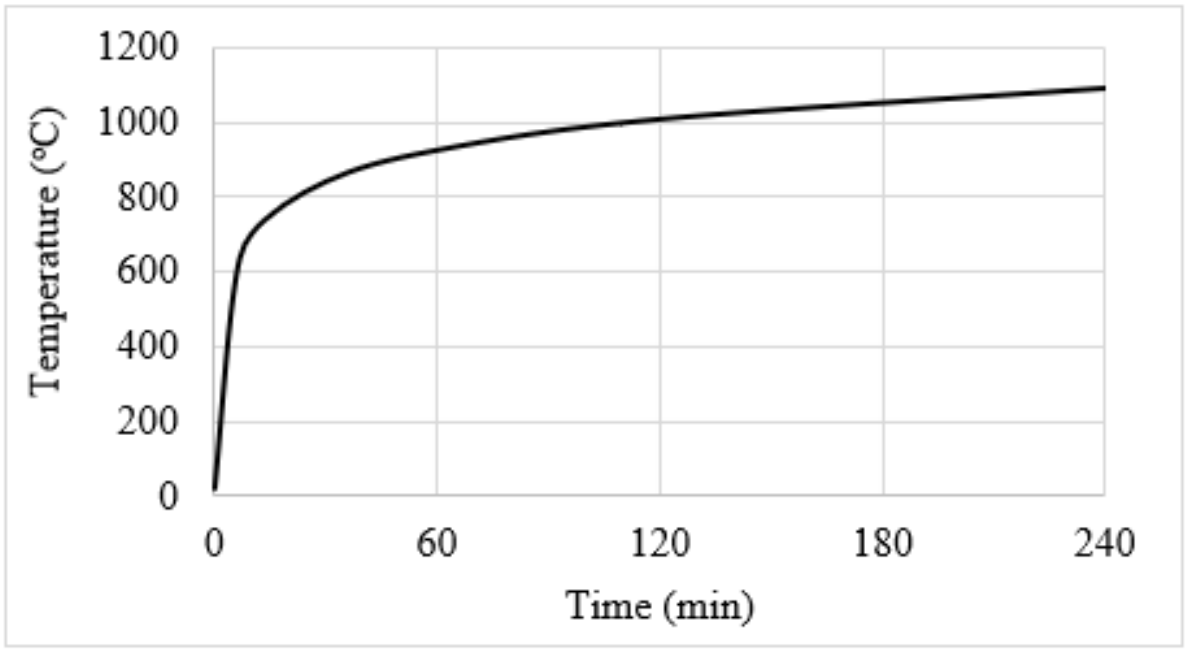
Figure 5. ASTM E119 fire exposure scenario used in the numerical studies.